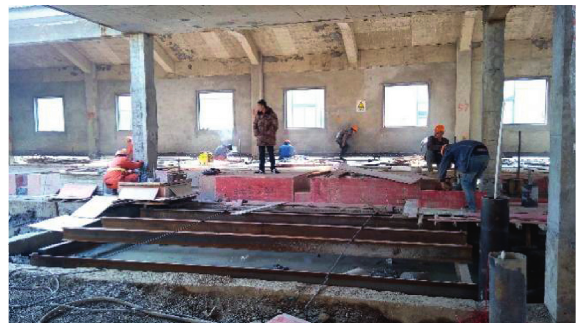
Figure 7: Formwork for the first